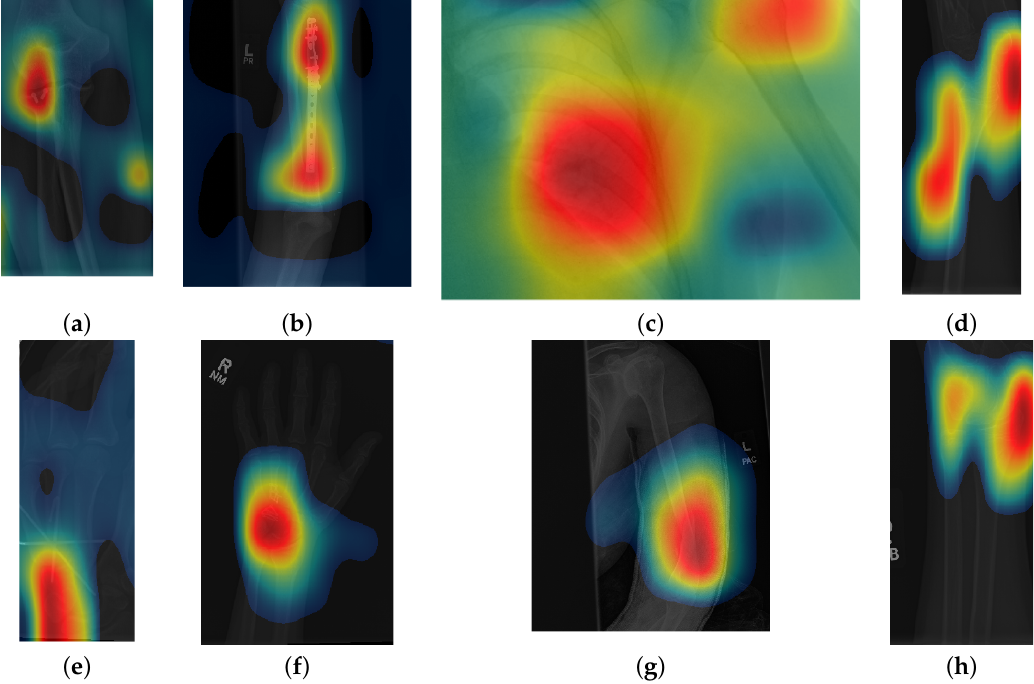
Figure 10. Illustration of activation maps overlaid over the eight radiographs with abnormalities of Figure 2 to indicate the regions of the image that activated an Inception-ResNet-v2 architecture. As for the cases without abnormalities, the activation regions are more located, e.g., (( c ) Shoulder,( d ) Lateral view of Wrist, and ( h ) Posterior-Anterior view of Wrist)) and in addition, the abnormalities are better located, e.g., (( a ) Elbow, ( b ) Forearm, ( e ) Finger, ( f ) Hand, and ( g )